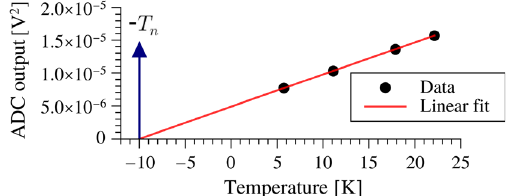
Fig. 5 Measurement of noise temperature and gain of the detection electronics. The statistical error for each point is smaller than the size of the symbol. In the plot the mean square amplitude of the ADC output is plotted vs T r . The noise temperature at the input of A1 is 10 L / 10 × T n = 8 . 0K, where L = − 1 . 0dB are the measured losses between R J and A1